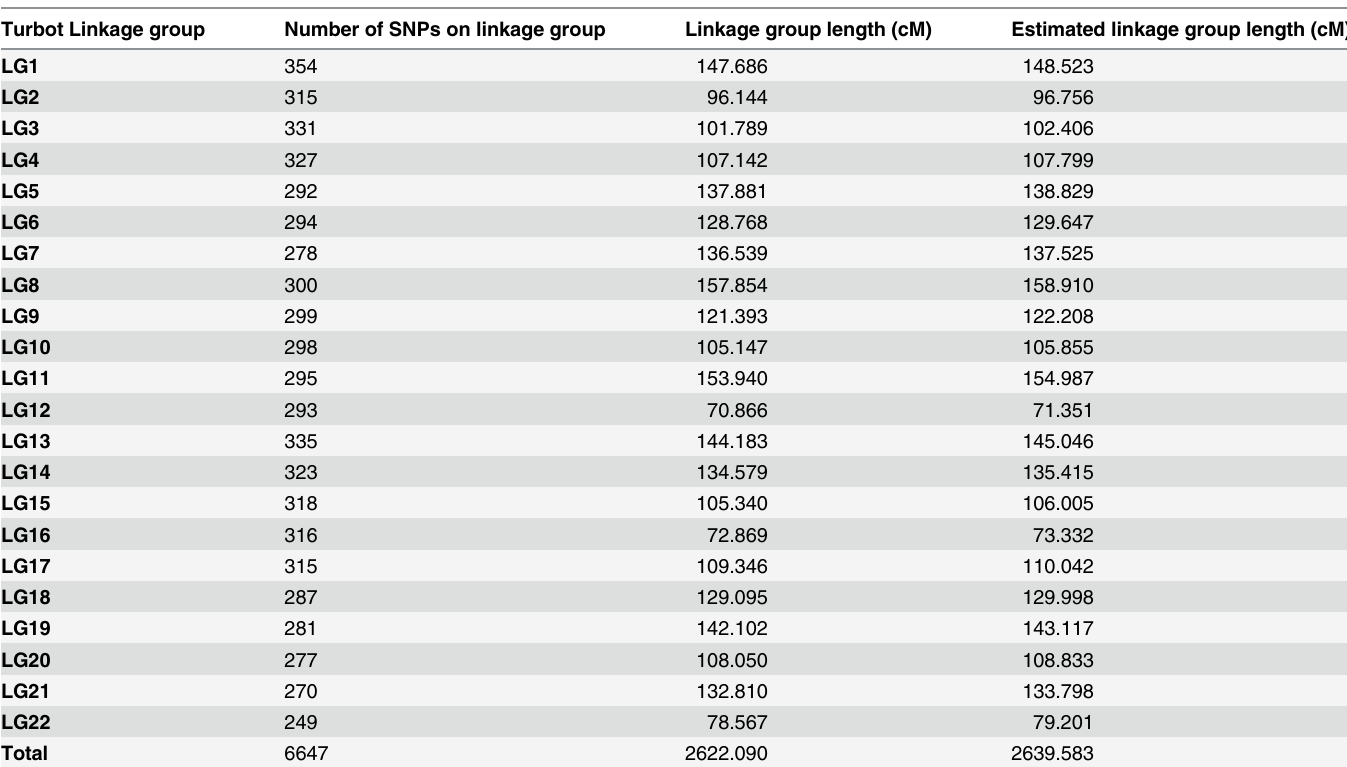
Table 3. Number of SNP in each linkage group and linkage group lengths (observed and estimated).